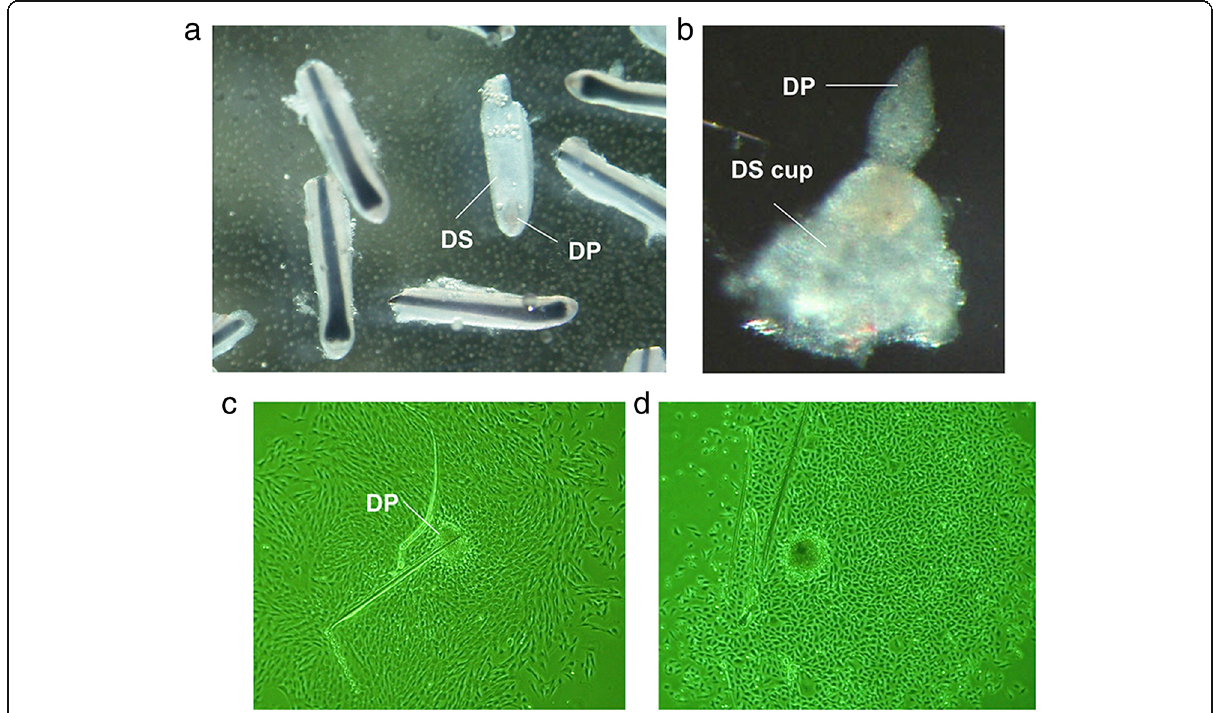
Fig. 6 Preparation of trichogenic dermal cells for successful HF induction. a Microdissected lower portion of human HFs. The dermal papilla (DP) and the dermal sheath (DS) are respectively indicated. b High magnification image of DP and the “ flipped ” cup shape portion of DS. Note that two components are continuous. c In vitro expansion of human DP. d Restoration of DP properties in DP activation culture condition (DPAC). Note that DP cell morphology is distinct from that shown in ( c